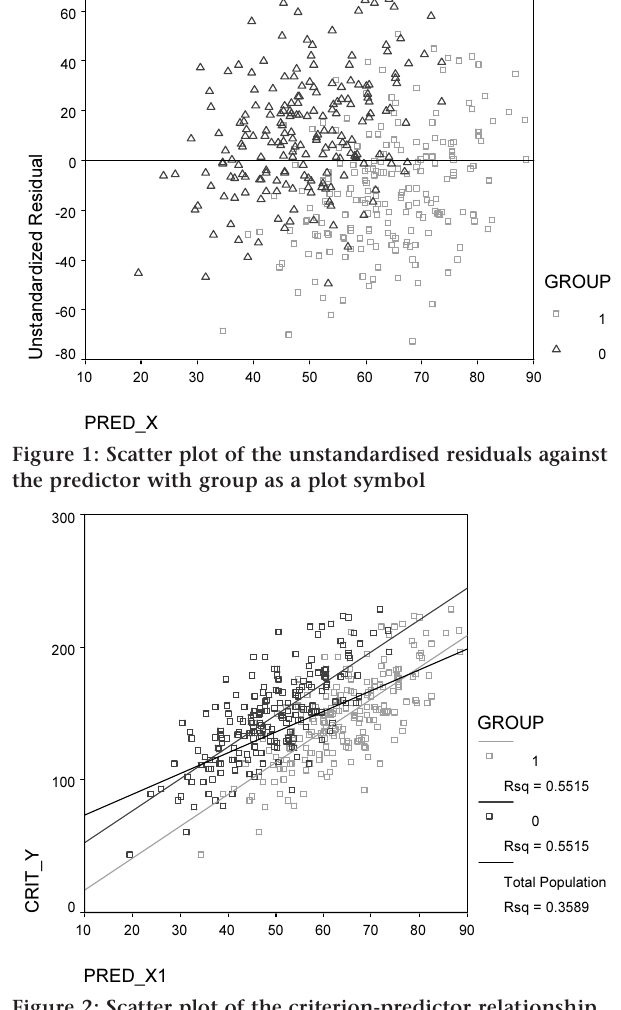
Figure 2: Scatter plot of the criterion-predictor relationship with group membership as plot symbol